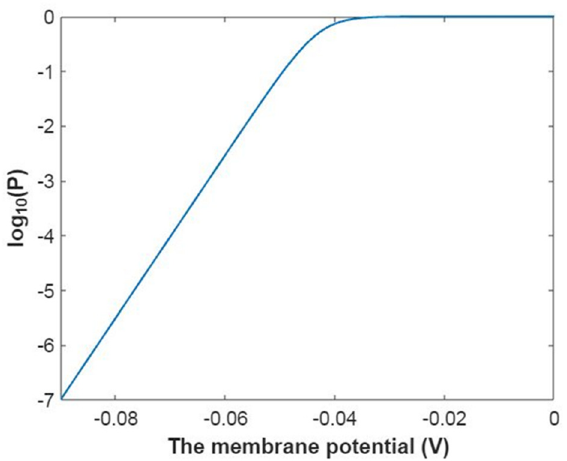
Figure 1. The relationship between the membrane potential and the common logarithm of the open probability of sodium channels at G = − 6.33 J and over membrane potential range from − 0.09 V to 0 V.